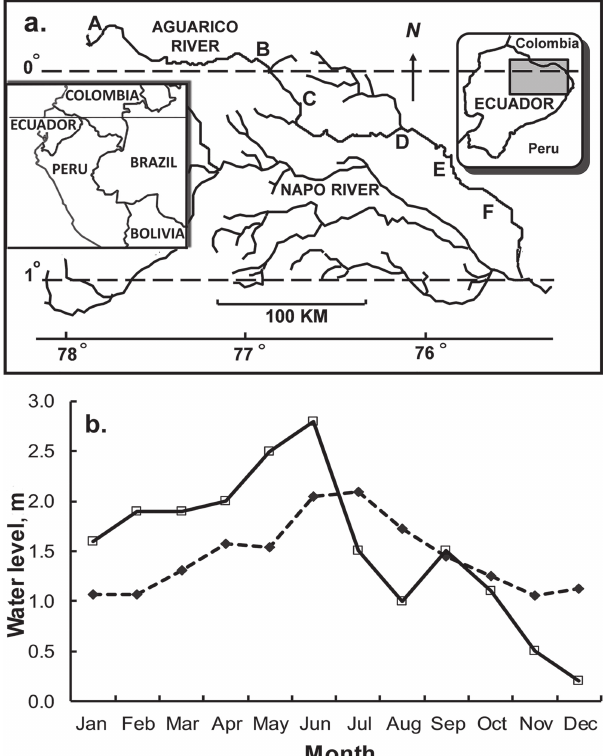
Fig. 1. a. Map of the Napo region in Ecuador and the collecting locations of Prochilodus nigricans in the Aguarico River in 1999 (see Tab. 1 for details). A. Due; B. Dureno; C. Chiritza; D. Cuyabeno; E. Sábalo; and F. Yanayacu/Zancudo. Location of our study area within Ecuador is indicated by shaded box in upper-right inset; location of Ecuador relative to neighboring countries in Western Amazon is indicated in inset on center- left. b. Mean monthly water level relative to a base level for low flood periods in the Aguarico River. Data for 1999 (solid line) were based on our field observations recorded at Chiritza. Averaged data from 1981-1986 (dashed line) were based on monthly records from near Due provided by Ecuadorian Institute of Meteorology and Hydrology